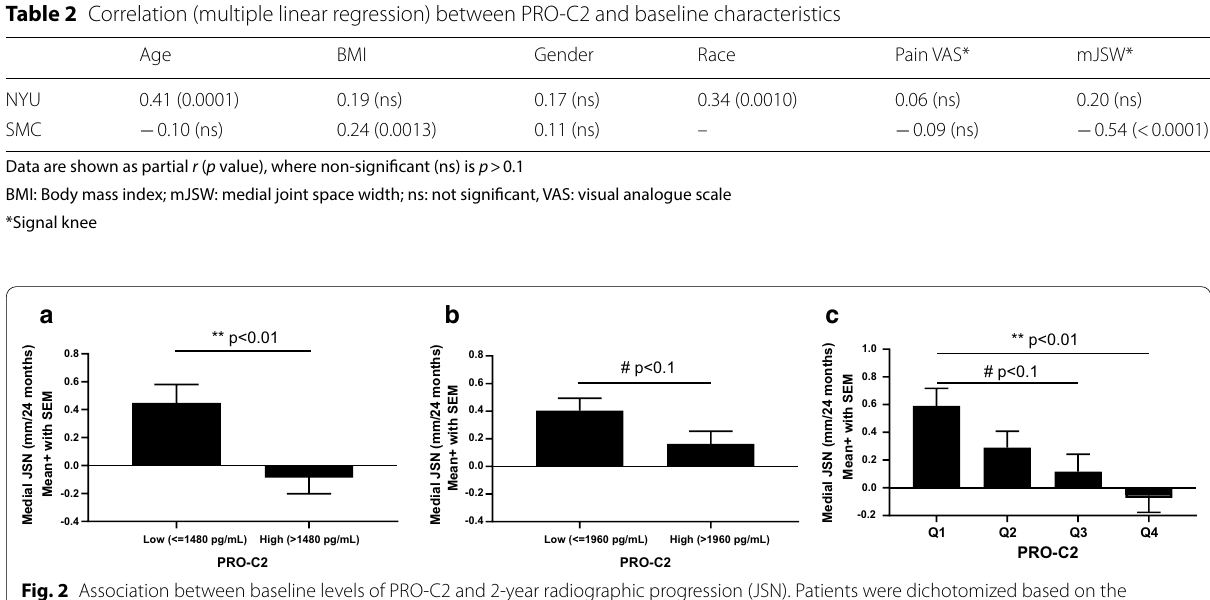
group compared with the higher PRO-C2 group of the placebo arm: mean difference was 0.24 ( p